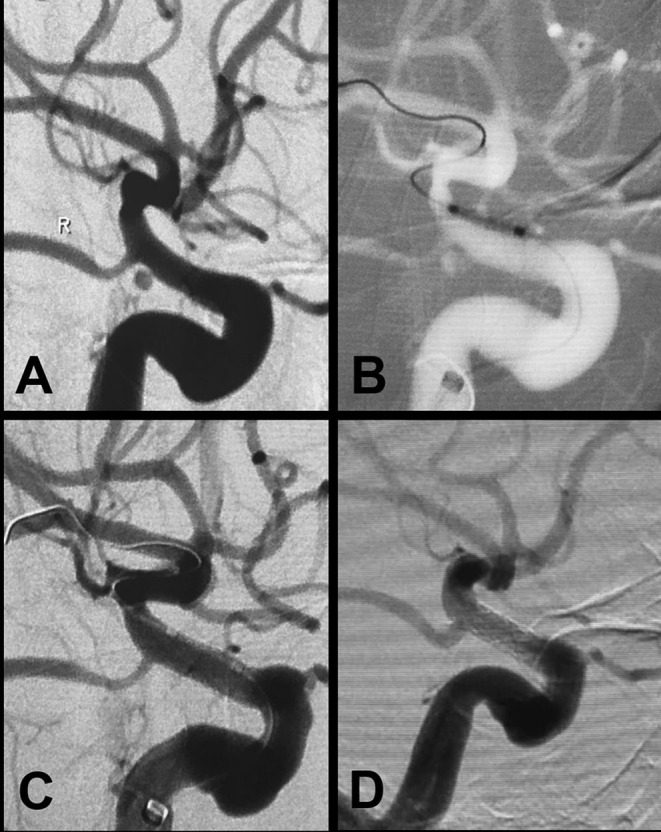
A blood blister-like aneurysm at the ophthalmic segment of the ICA treated with the Willis covered stent. (A) Preprocedural digital subtraction angiography reveals a blood blister-like aneurysm (2.5 × 1.6 mm) in the posterior wall of the ophthalmic segment of the ICA. (B) The Willis covered stent (3.5 × 7 mm) was precisely delivered to the location of the aneurysm under roadmap-mask guidance. (C) Cerebral angiography immediately after stent placement demonstrates complete occlusion of the aneurysm with parent artery patency. (D) Twelve-month follow-up digital subtraction angiography shows complete obliteration of the aneurysm with no parent artery stenosis.